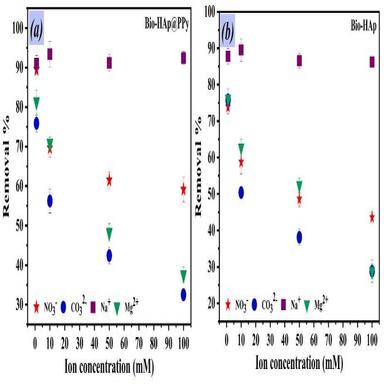
Effect of anions (NO3 − and CO3 2− ) and cations (Na+ and Mg2+) on OTC Removal by Both Materials.